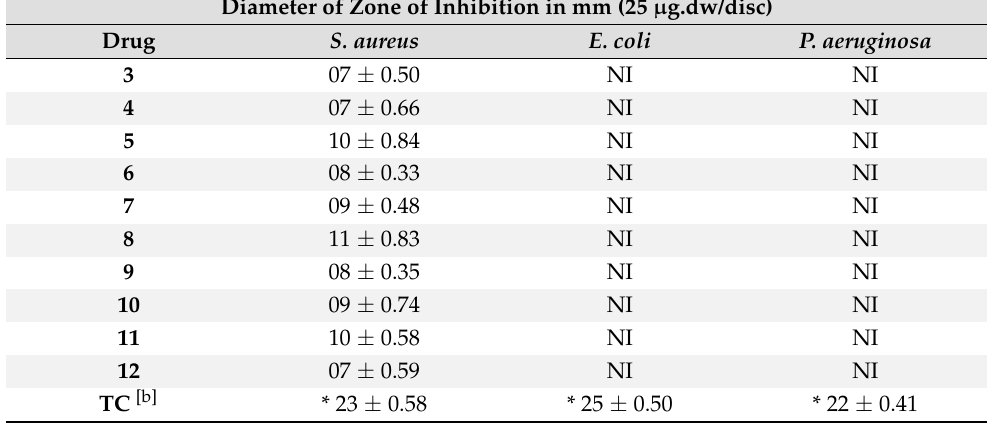
Table 3. Antibacterial effects of SEs 4 – 12